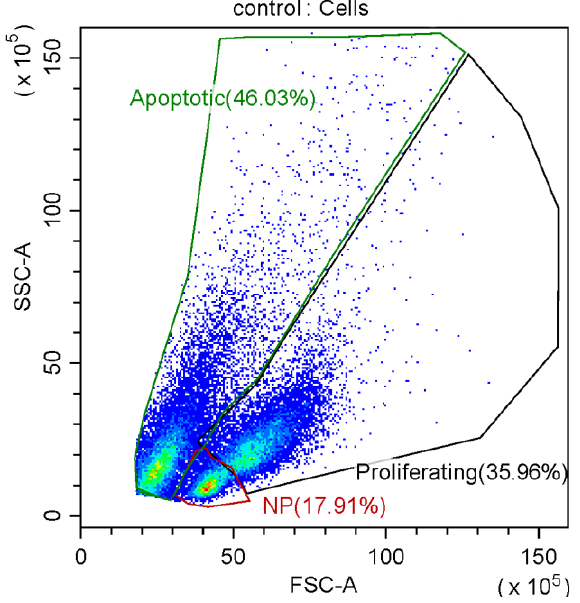
Figure 4. Example of differential gating dot plot. Note: NP — non-proliferating cells.